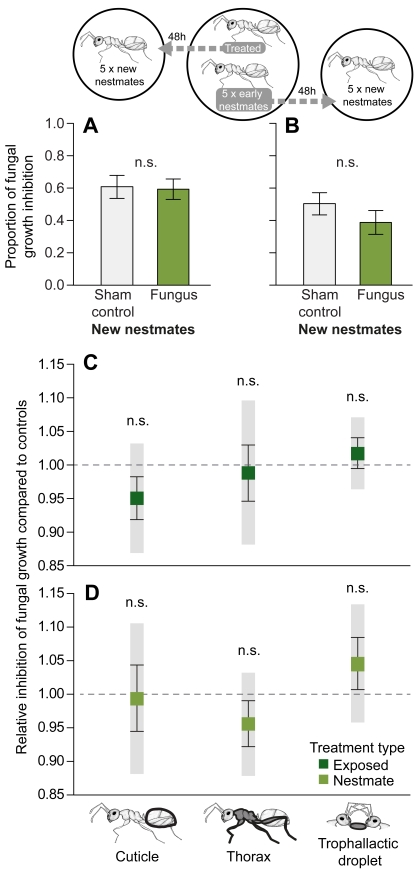
Antifungal activity measures to test for passive transfer of antimicrobial substances.(A, B) Antifungal activity of “new nestmates” of (A) directly treated ants and (B) early nestmates (n = 10 samples per group, each sample consisting of a pool of five individuals) for sham control (light grey) and fungus treatment (light green). The groups did not differ from one another. Bars show mean ± SEM of proportional antifungal activity compared to the growth control; n.s., non-significant. (C, D) Antifungal properties of the exterior and interior of fungus-exposed individuals compared to control individuals for the directly treated ants (C) and their respective nestmates (D). We found no difference in the potentially transferable substances from the body surface (cuticle of the ant gaster) and the thorax including the antimicrobially active metapleural glands, nor the trophallactic droplet between individuals treated with a sham control, or with the fungus (dark green for directly exposed individuals, light green for their nestmates). The antifungal activity of control-treated individuals (respectively, their nestmates) is given as a dotted line. Boxplots with whiskers represent mean ± SEM proportion and 95% confidence intervals (indicated in grey shading) of fungal growth inhibition of the ants from the fungus treatment, all standardised to the sham control (n = 10 samples per treatment, except for cuticle and thorax samples: n = 6 per group; each sample consisted of a pool of 5 ants); n.s., non-significant.